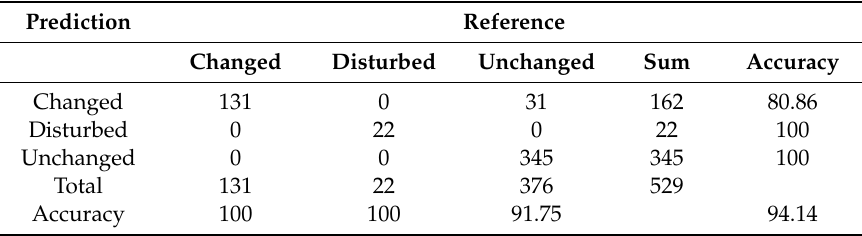
Table 4. Cross-validation results of classification